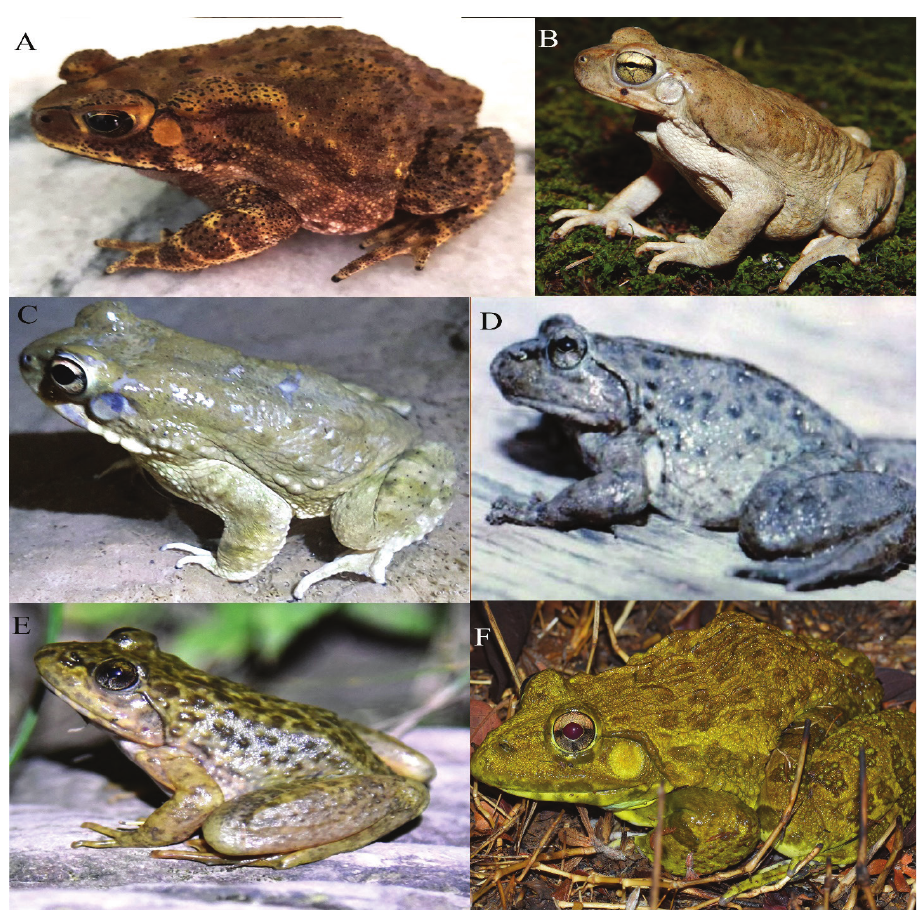
Figure 2. A Asian Common Toad or Black-spined Toad ( Duttaphrynus melanostictus ) B Olive Toad ( Du- ttaphrynus olivaceus ) C Indus Valley Toad ( Duttaphrynus stomaticus ) D Kashmir Torrent Frog ( Allopaa barmoachensis ) E Hazara Torrent Frog ( Allopaa hazarensis ) F Indus Valley Bull Frog ( Hoplobatrachus ti- gerinus ). Photographers: Dr Muhammad Rais ( A , C , E ); Dr Spartak Litvinchuk ( B ); Muhammad Sharif Khan ( D ); Janis Czurda ( F